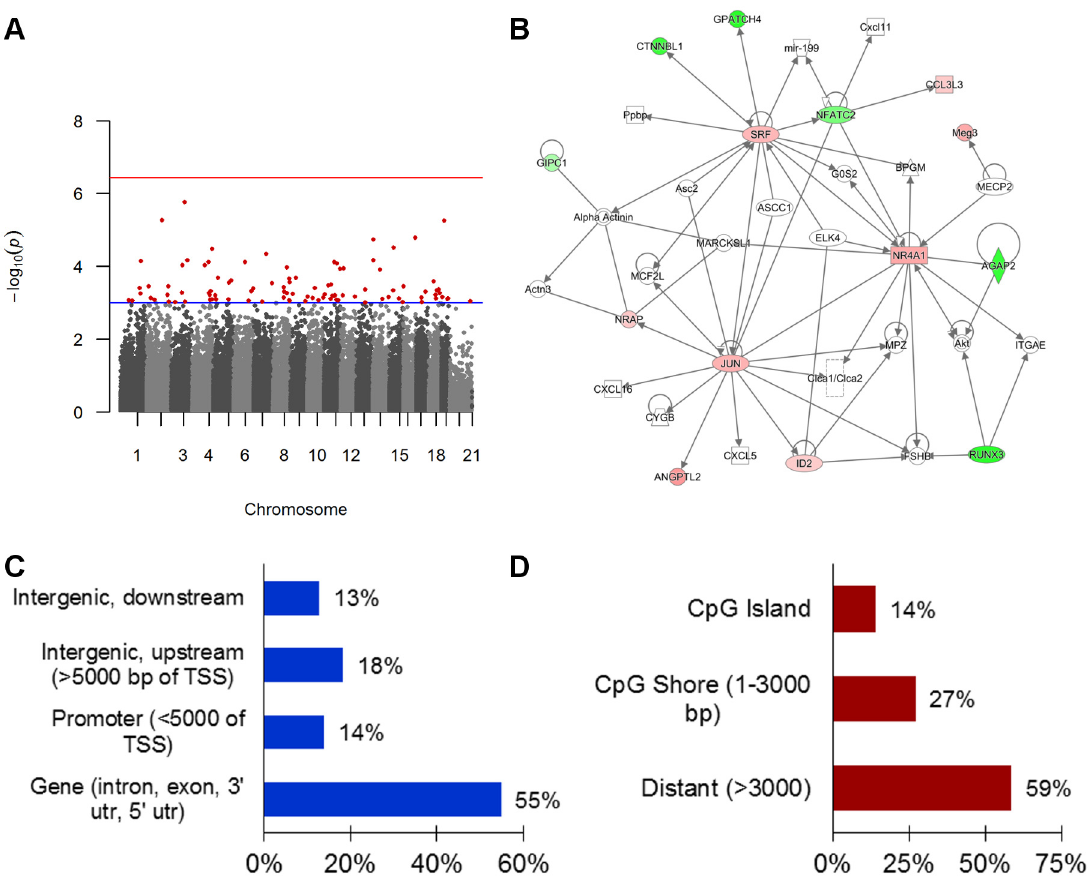
Fig 2. DMRs lack genome-wide association with in utero cigarette smoke exposure in allergic airway disease. (A) Manhattan plot of the p-values from a weighted beta regression for HDM-treated CS vs. HDM-treated FA mice. Each dot represents a p-value for correlating CpG clusters as identified through A- clustering with a minimum of 3 adjacent CpGs within a cluster. The red horizontal line is the estimated genome-wide significance threshold of p = 3.6 x 10 − 7 ; the blue line is the threshold for suggestive association (p = 0.001). Red dots denote suggestive DMRs with an unadjusted p-value < 0.001 (n = 99). (B) A molecular network identified by Ingenuity Pathway Analysis of the genes nearest to the 99 DMRs. This network demonstrates that these genes have a number of direct and shared interactions with each other. Network analysis was performed using only direct interactions and a minimum network score of 20. Legend: genes are colored red (hypermethylated) or green (hypomethylated), horizontal ellipse = transcriptional regulator, square = cytokine, double circle = group/complex, vertical diamond = enzyme, vertical rectangle = G-protein coupled receptor, circle = other, and triangle = phosphatase. Genomic distribution of the top 99 DMRs by relationship to (C) gene and (D) CpG